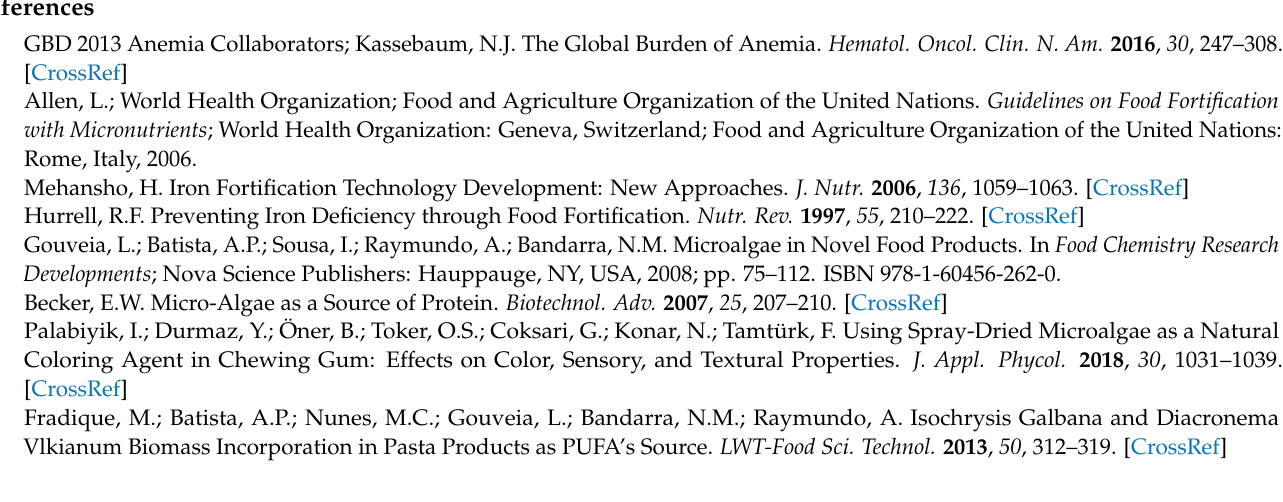
Table S2. Moisture, dry matter, protein and fat content of experimental flours, Table S3. Panelist demographics, Table S4. Effect of encapsulation of moisture content of flour, Table S5. Normality and variance homogeneity test of variables, Figure S1. Experimental design of shelf-life study, Figure S2. Hedonic scores of Indian panelists on day 0, Figure S3. JAR scores (% Indian panelists) on day 0, Figure S4. Hedonic scores of Indian panelists on day 21, Figure S5. JAR scores (% Indian panelists) on day